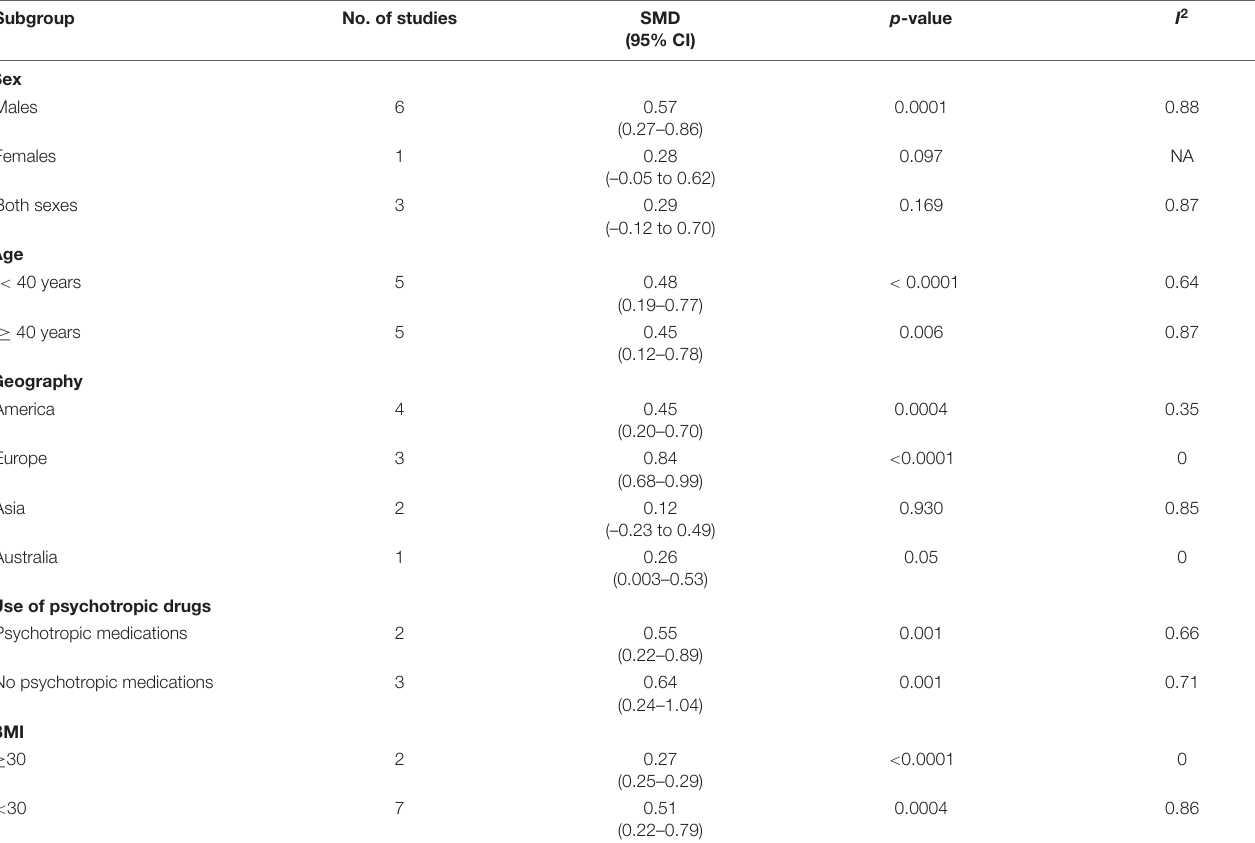
TABLE 5 | Subgroup analyses for studies included in the analysis that assessed the triglyceride (TG) levels in PTSD patients vs. Healthy Controls.